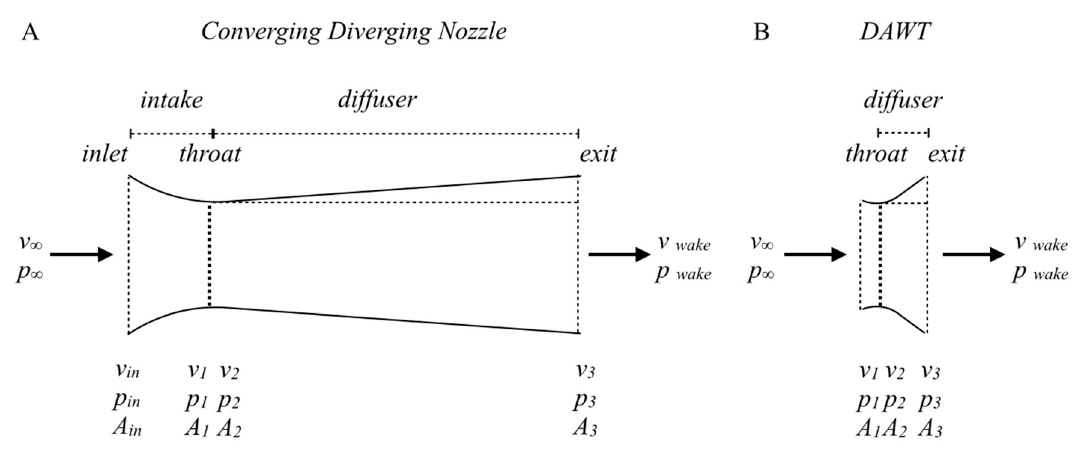
Figure 1. Cross-section schematic of passive accelerator types with stations. ( A ) Converging Nozzle [15]; ( B ) Diffuser Augmented Wind Turbine (DAWT).